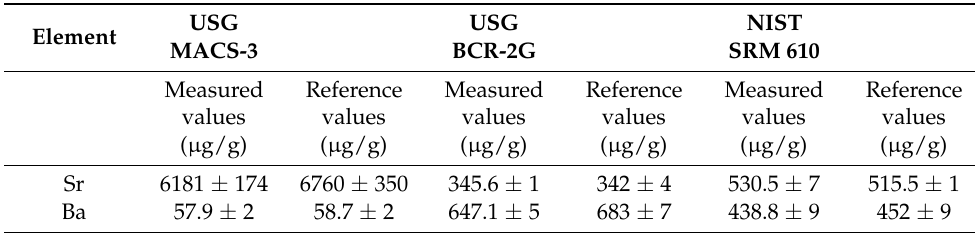
Table 2. Average concentrations and standard deviations ( ± 1 σ ) of strontium and barium in reference materials USGS MACS-3, USGS BCR-2G and NIST SRM 610 as determined during the